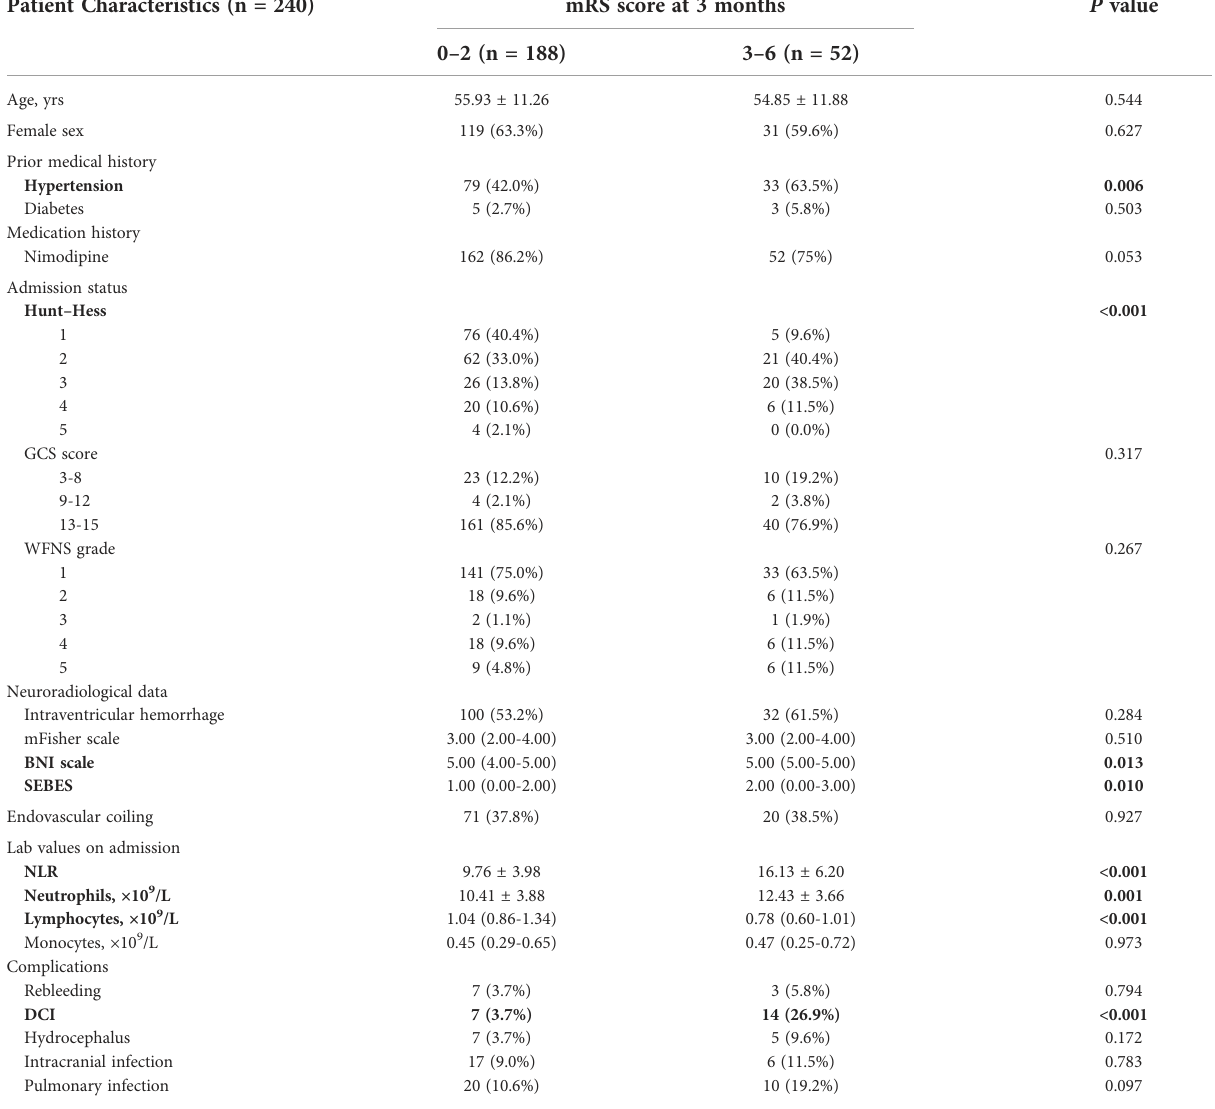
TABLE 1 Patient characteristics.